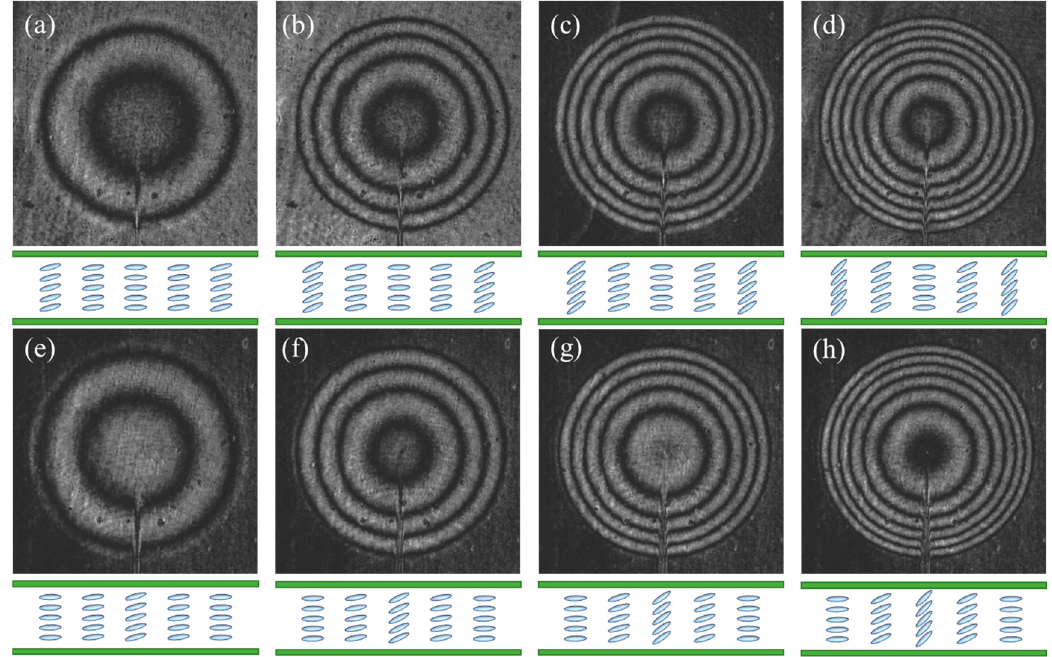
Figure 8. Interference fringes and the corresponding schematic illustration of LC directors: ( a – d ) positive-lens states, ( e – h ) negative-lens states. ( a ) V 1 = 1.6, V 2 = 1.8, ( b ) V 1 = 1.6, V 2 = 2.0, ( c ) V 1 = 1.6, V 2 = 2.2, ( d ) V 1 = 1.6, V 2 = 2.4, ( e ) V 1 = 1.8, V 2 = 1.6, ( f ) V 1 = 2.0, V 2 = 1.6 ( g ) V 1 = 2.2, V 2 = 1.6 and ( h ) V 1 = 2.4, V 2 = 1.6 ( V rms value, f = 1 kHz, λ = 457